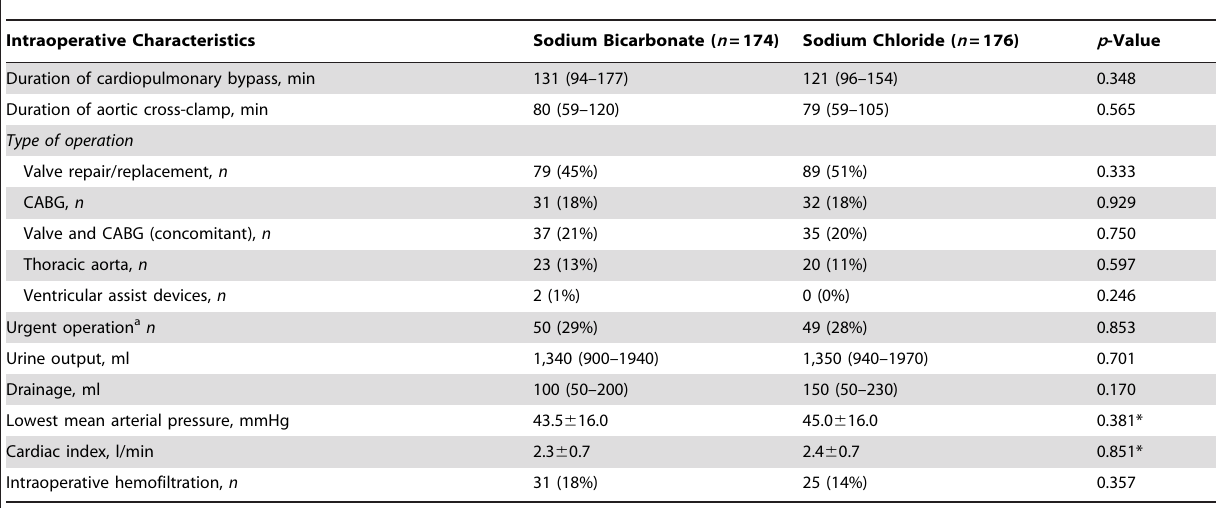
Table 3. Intraoperative